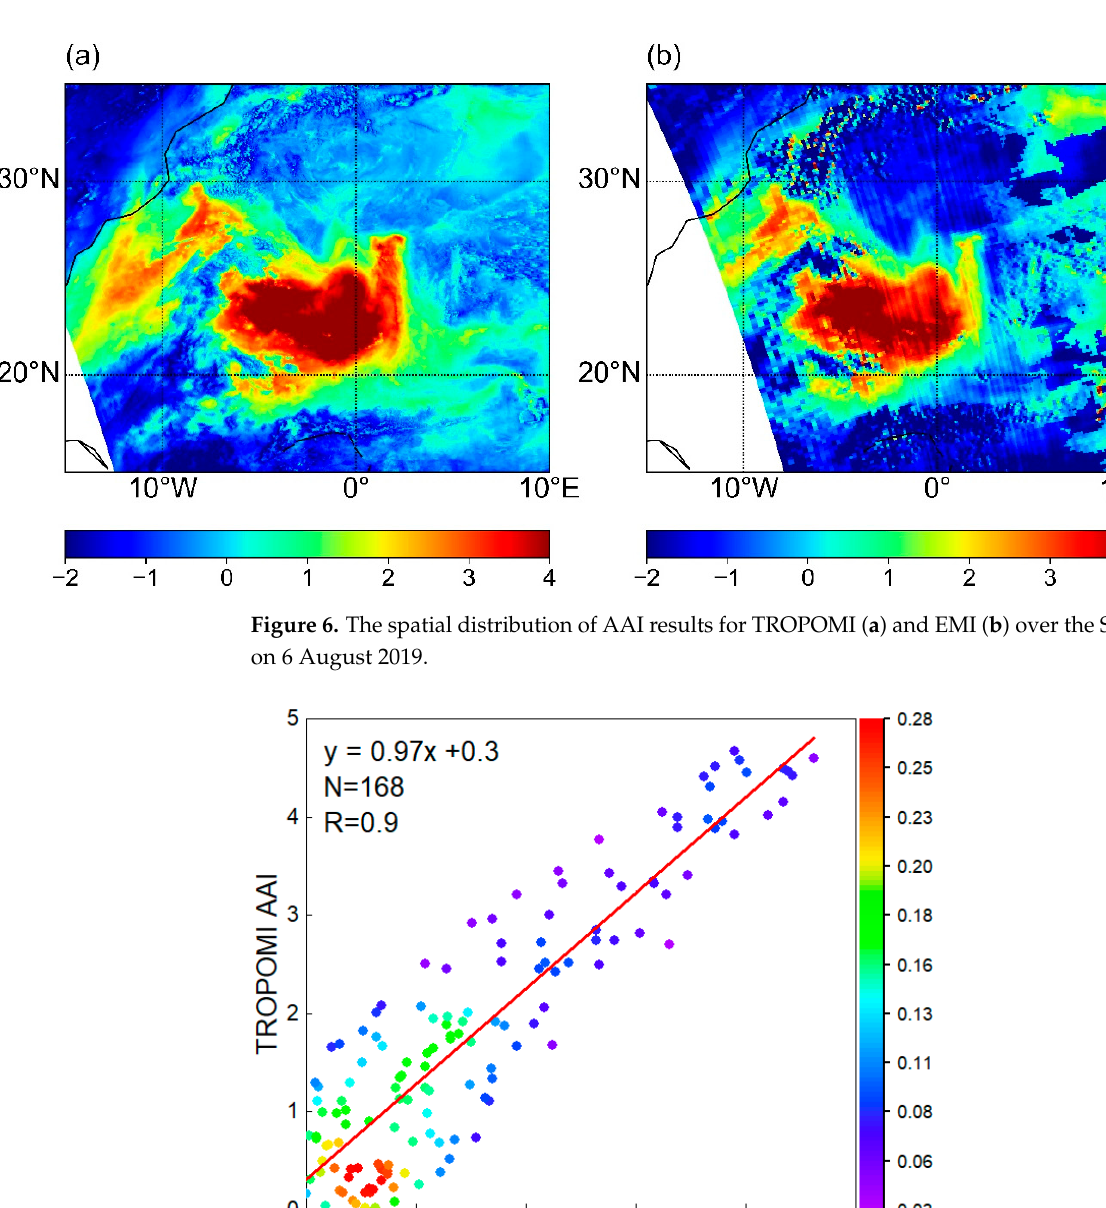
Figure 7. AAI comparisons between TROPOMI and EMI over the Sahara region on 6 August 2019.